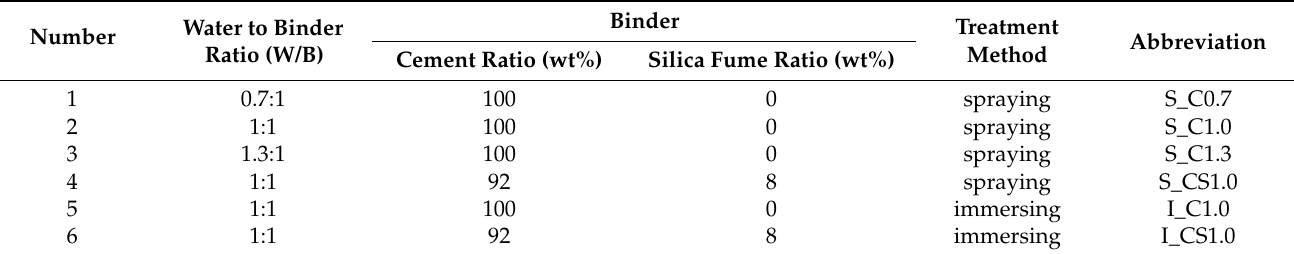
Table 4. Proportions of cement-based slurries and treatment